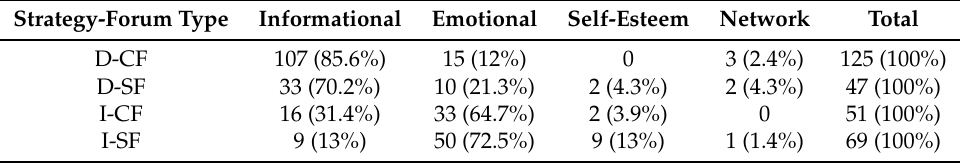
Table 10. Seeking strategy, type of support provided, and forum type (D = Direct; I = Indirect).